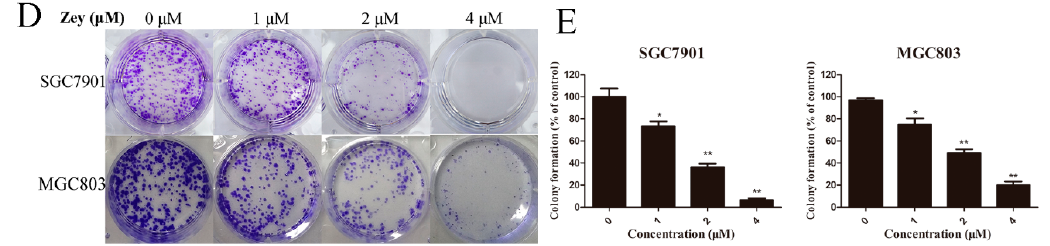
Figure 1. Zeylenone (Zey) effectively suppresses cell viability and colony formation in SGC7901 and MGC803 cells. ( A ) Chemical structure of Zey. ( B ) Zey suppresses the viability of SGC7901 and MGC803 cells determined in an MTT assay. Cells were treated with Zey (0, 2.96, 5.92, 11.84, 23.68, or 47.37 μ M) for 24 h. Data are expressed as means ± SD of three distinct experiments. The cell viability of the control (DMSO only) is indicated as 100%. * p < 0.05 and ** p < 0.01 vs. control cells. ( C ) Zey suppresses the viability of normal gastric epithelial (GES ‐ 1) cells determined in an MTT assay. GES ‐ 1 cells were treated with Zey (0, 1, 2, 4, 8, 16, 32, 64, or 128 μ M) for 24 h. Data are expressed as means ± SD of three distinct experiments. * p < 0.05 and ** p < 0.01 vs. control cells. ( D ) Representative images of colonies after SGC7901 and MGC803 cells were treated with Zey for 12 days. ( E ) Statistical analysis of colony numbers from three independent experiments. * p < 0.05 and ** p < 0.01 vs. control cells.